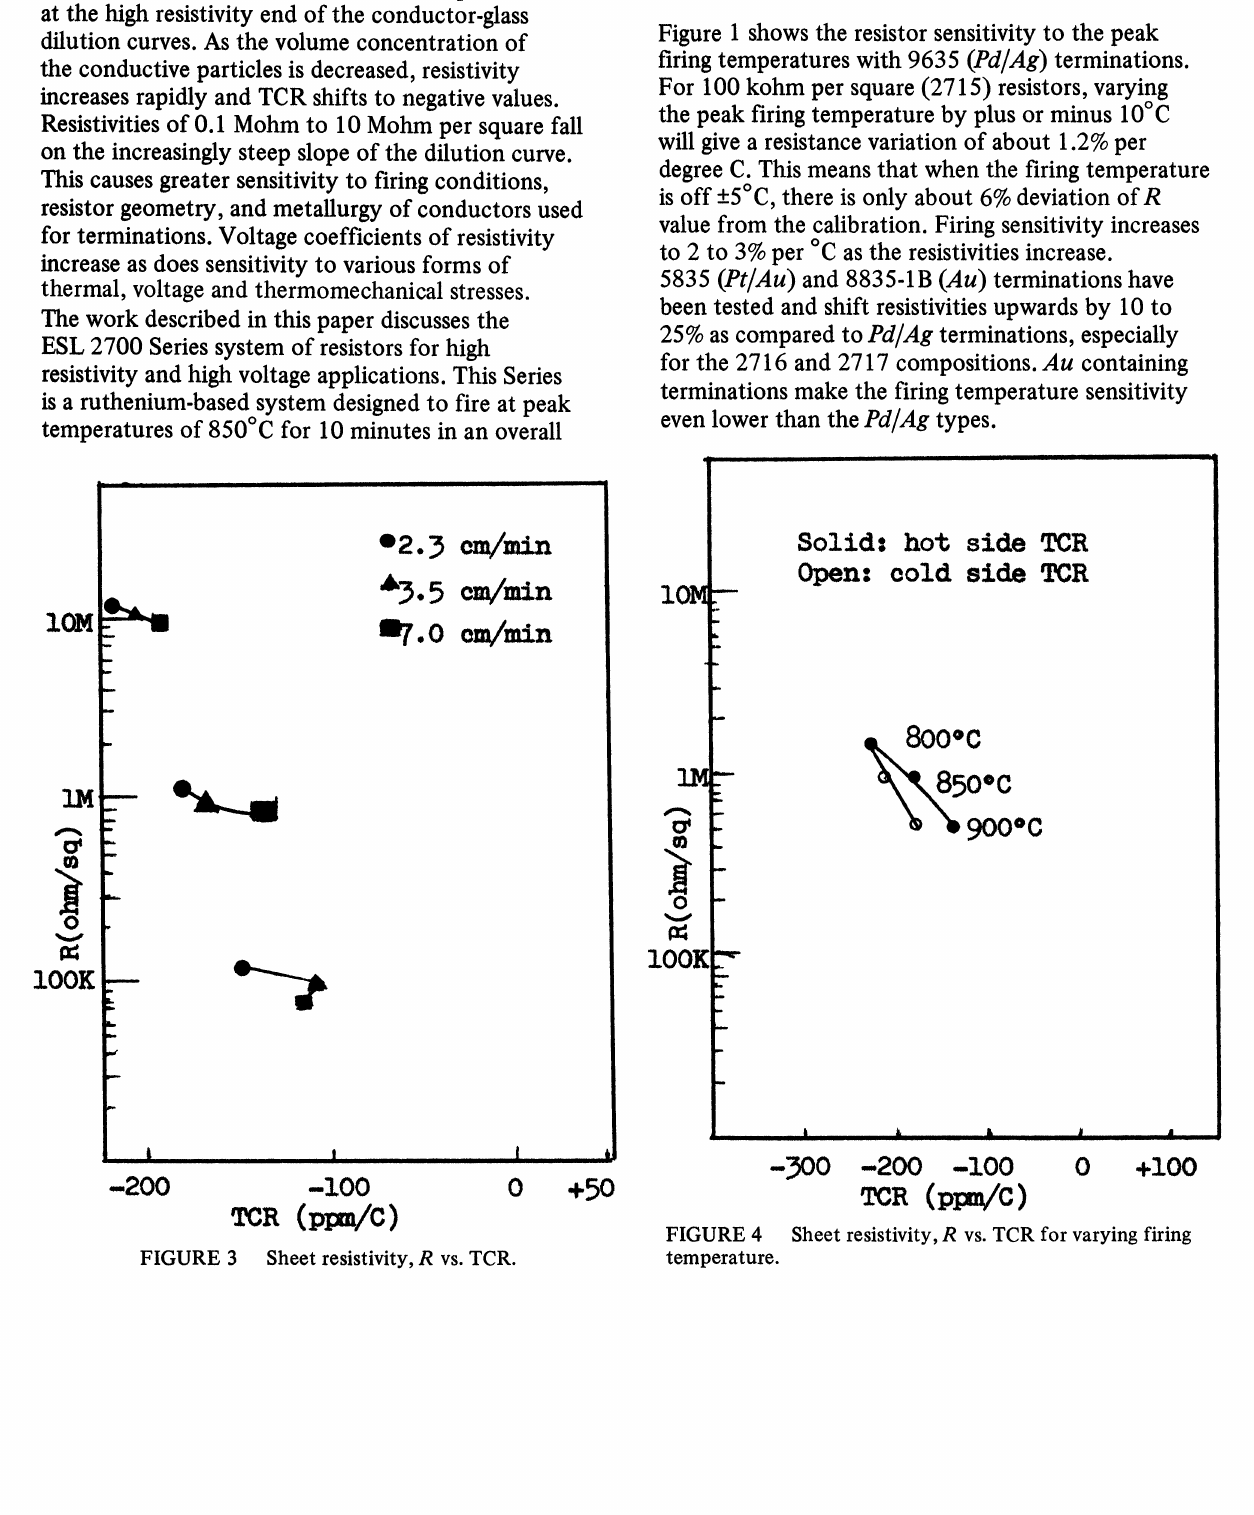
45 minute cycle in a belt furnace. It is limited to high resistivities and may be processed at the same time that other resistors of lower resistivities are being fired.